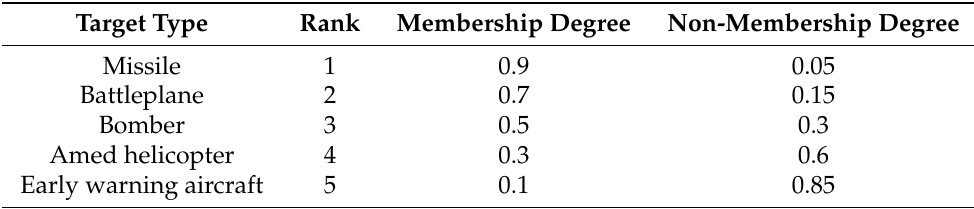
Table 1. Corresponding relationship between the target type and